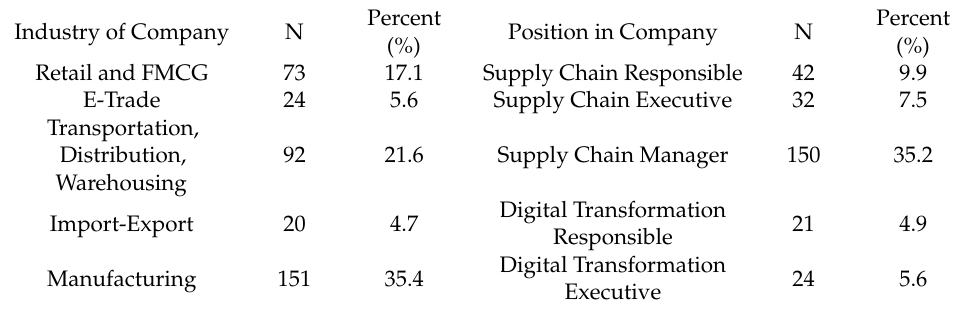
Table 6. Demographic characteristics of the participants. Industry of